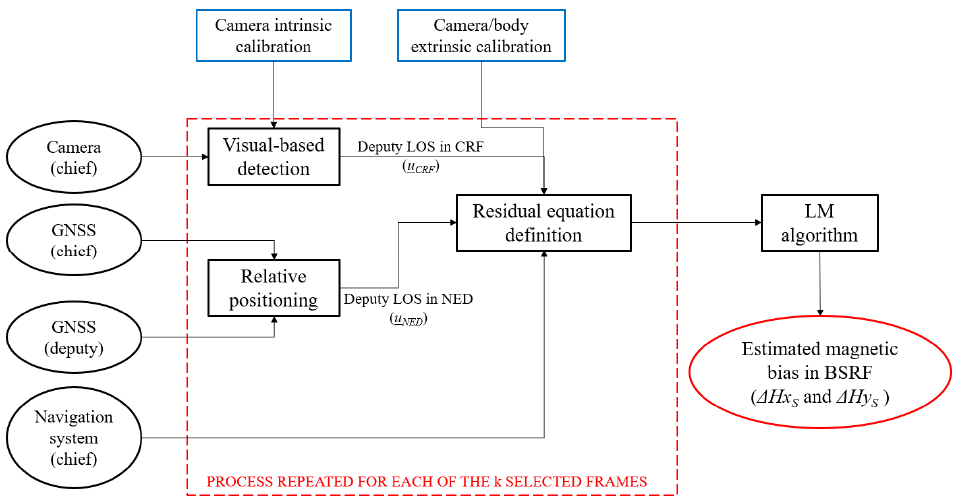
Figure 2. Cooperative strategy for magnetic sensor calibration. The camera and camera/body calibrations (blue rectangular boxes) are carried out offline. The final output is enclosed within an ellipse red box.